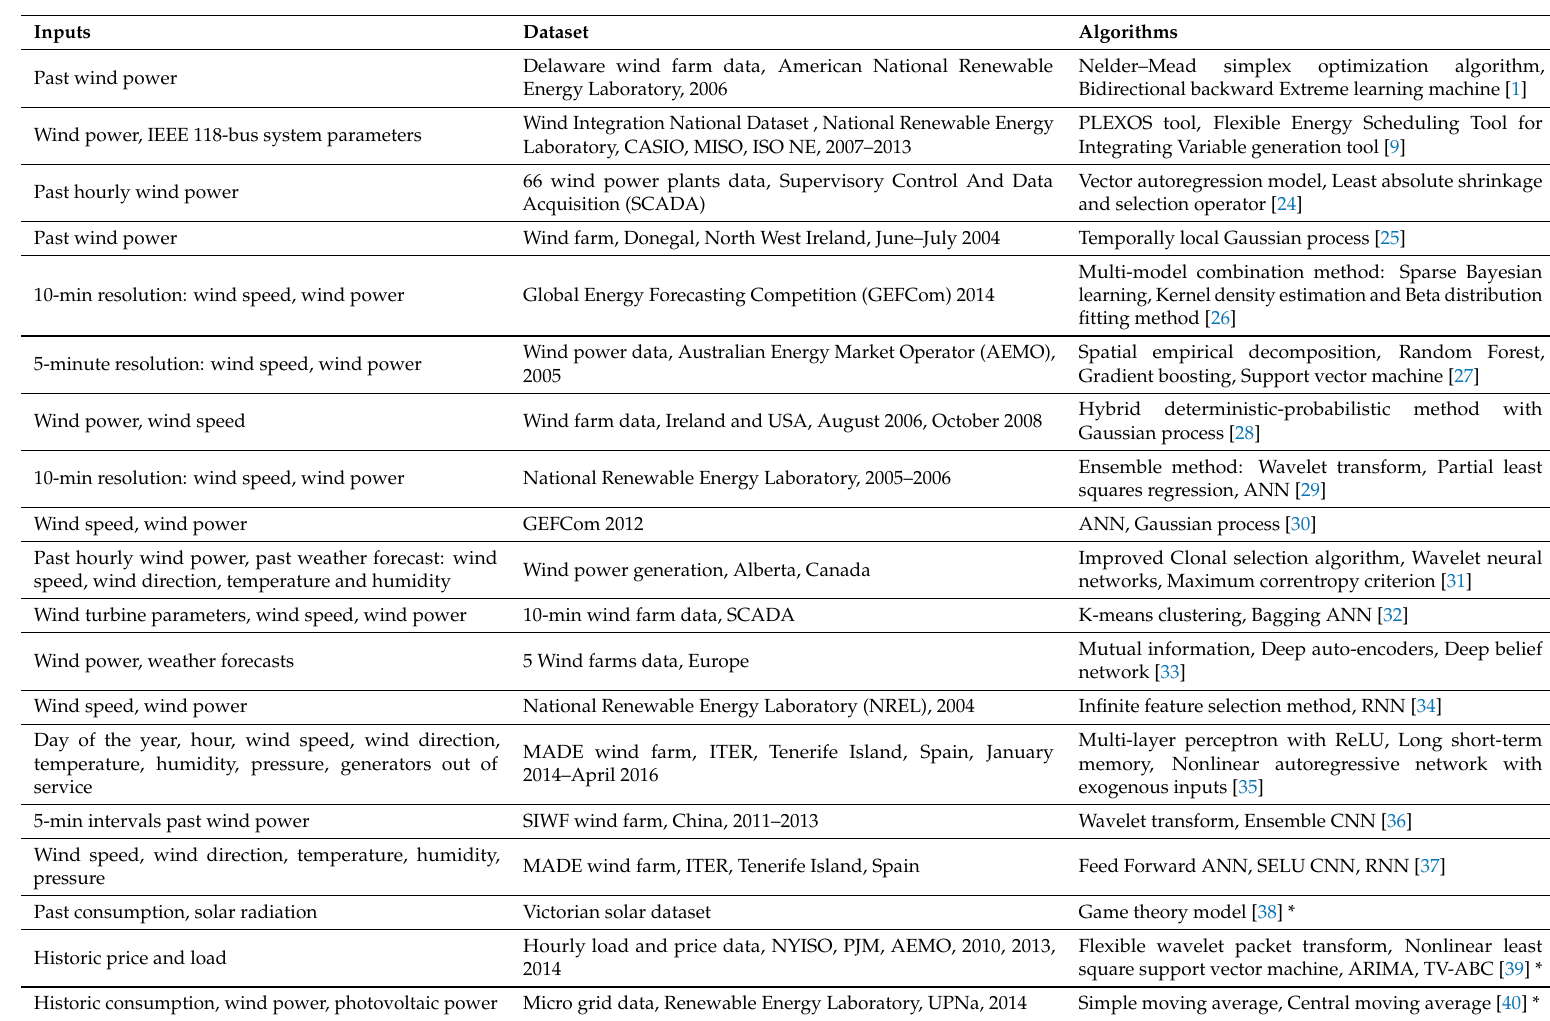
Table 1. Overview of related